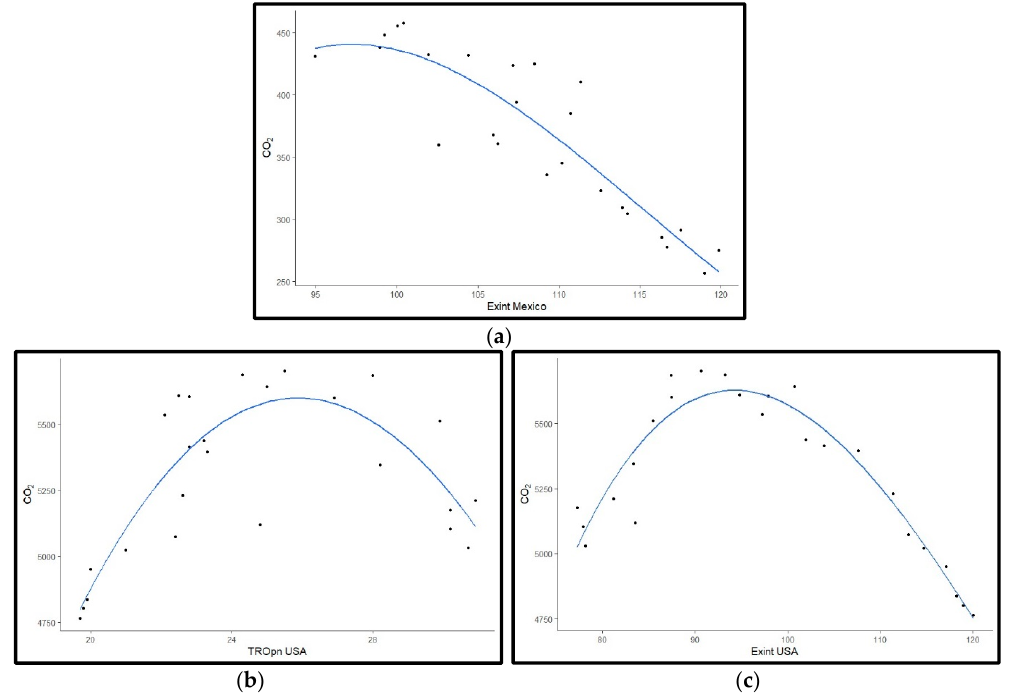
Figure 1. The environmental Kuznets curve: relationships detected by Mexico and the U.S.A. ( a ) Exint Mexico; ( b ) TROpn USA; ( c ) Exint USA.